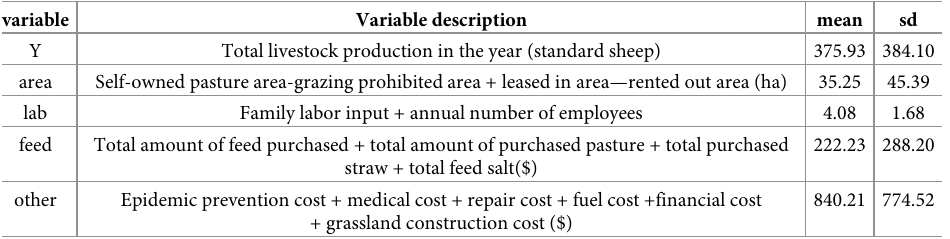
Table 1. Statistical description of input and output variables of herders’ livestock